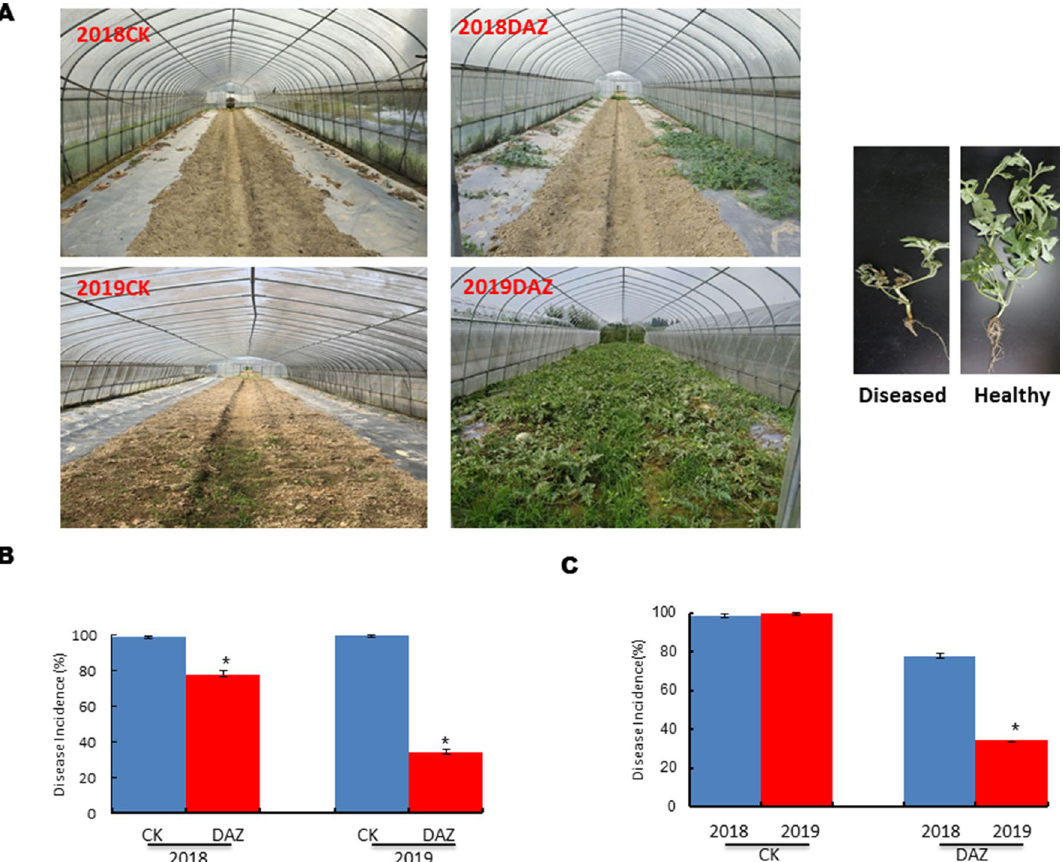
Figure 1. Effect of Dazomet application on Watermelon Fusarium wilt. ( A ) Growth of watermelon plants and plant morphology comparison in the field experiment after dazomet treatment compared with control. ( B ) Comparison of disease incidence by time effects. ( C ) Comparison of disease incidence by dazomet effects. DAZ dazomet treatment, CK control. Data are expressed as the means ± SD (n = 3). Differences between two groups were analyzed by student’s t test. *0.01 < P ≤